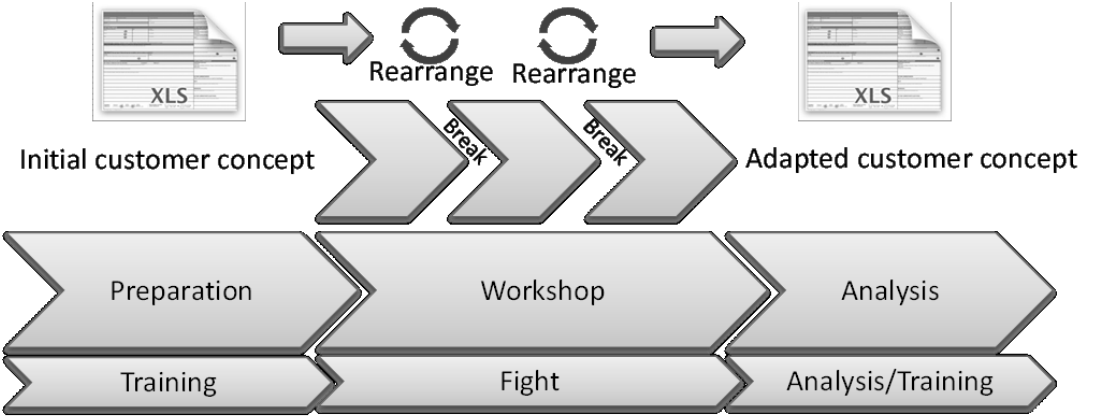
Figure 3. An overview of the overall process from preparation to